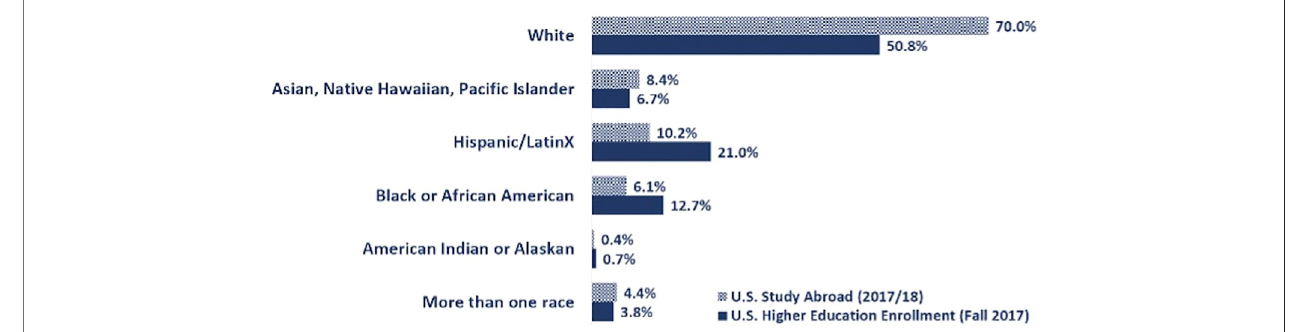
FIGURE2| ComparisonoftheRacialandEthnicdemographicsofundergraduatestudentsinU.S.HigherEducationandthosewhohaveparticipatedinU.S.Study